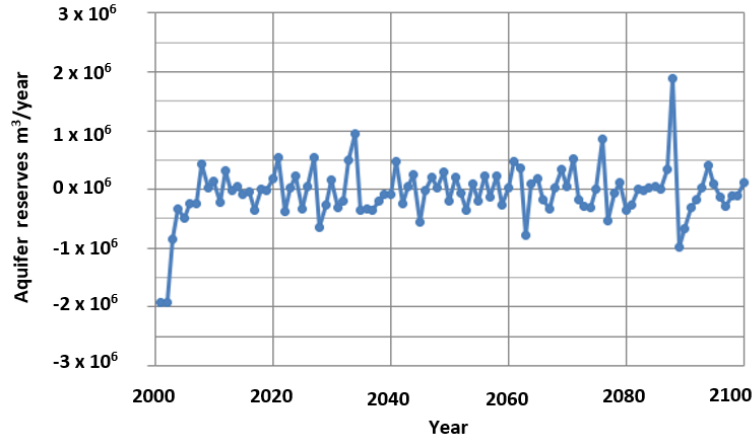
Figure 15. Changes in aquifer reserves from 2001 to 2100 under the RCP 2.6 scenario.